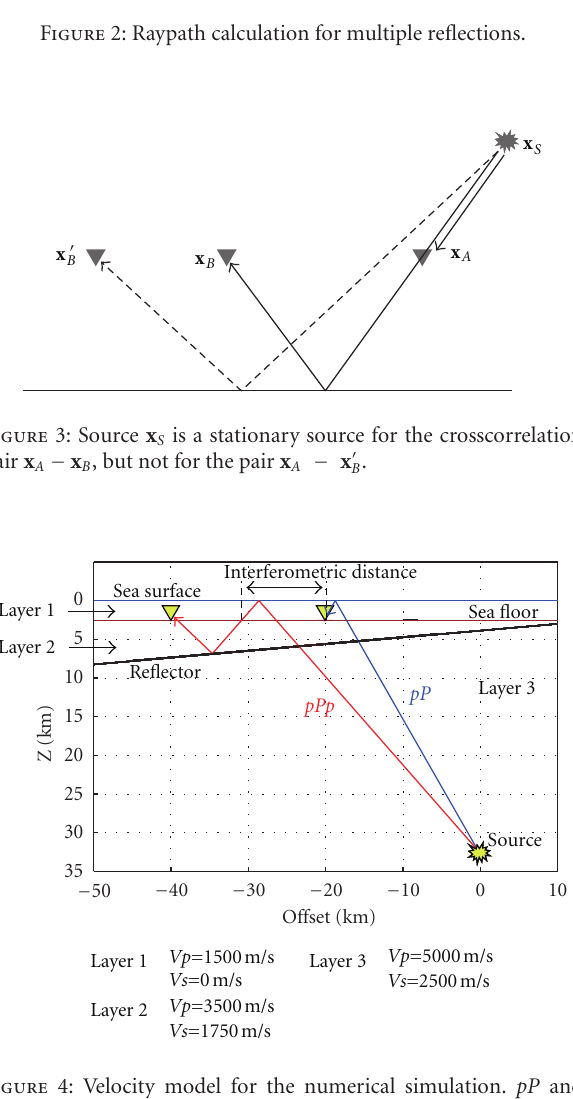
Figure 4: Velocity model for the numerical simulation. pP and pPp denote the sea-surface reflection and the sea-surface multiple reflection,